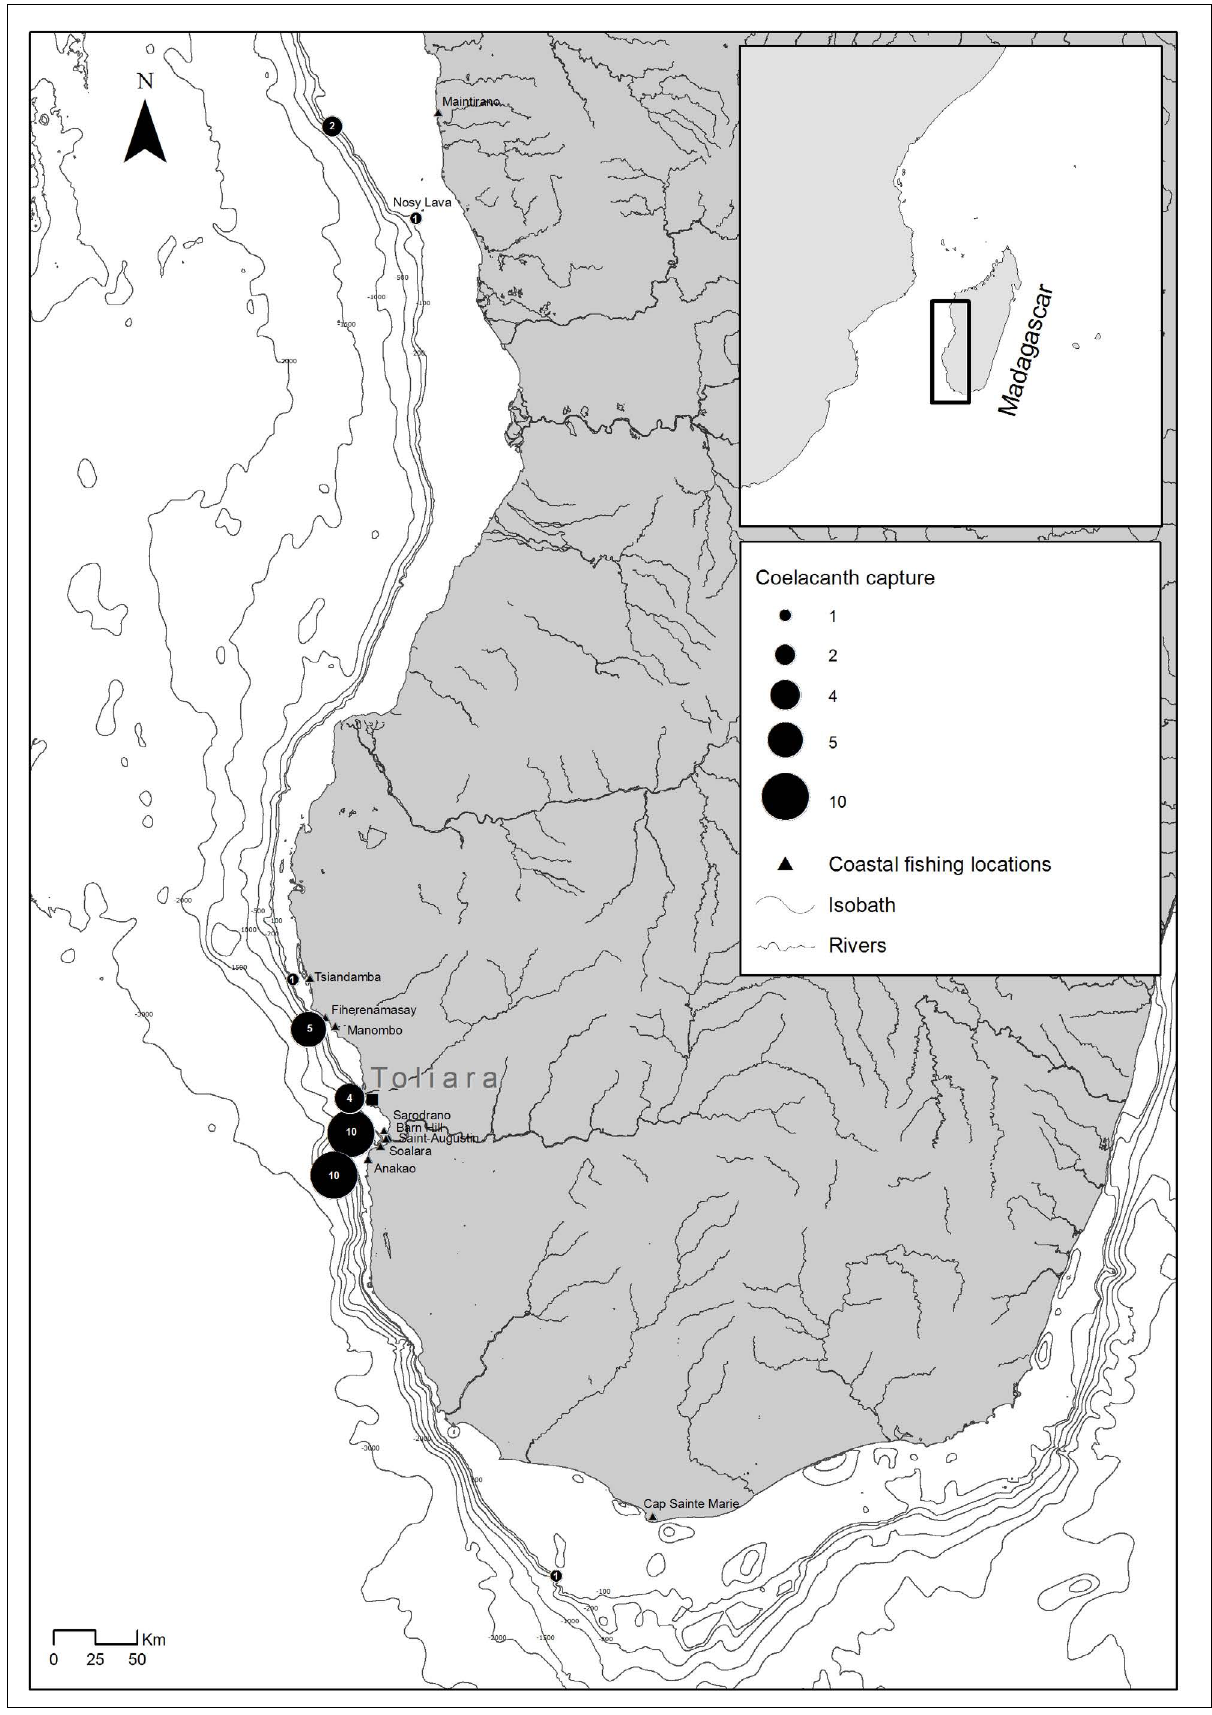
Figure 4: Map showing the location of captures from 1987 to 2019 of all coelacanths in Madagascar whose capture location is